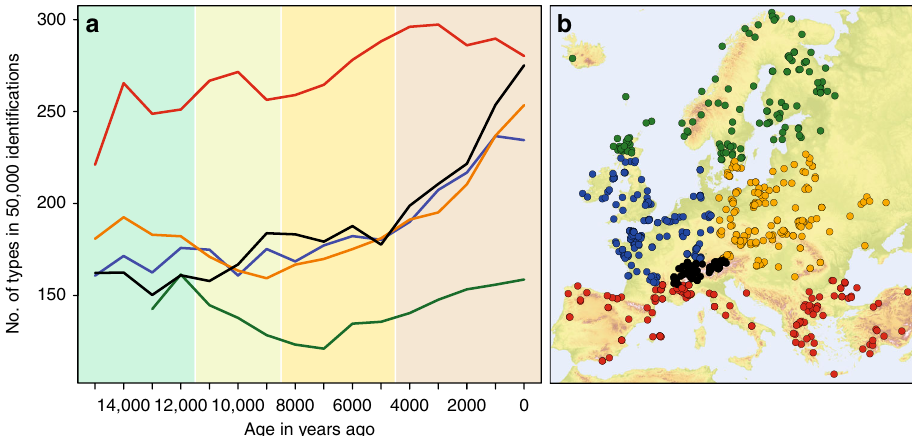
Fig. 1 Regional pollen type richness through time based on 749 pollen diagrams from Europe and Turkey. a Pollen type richness in regionally pooled samples with up to 10 7 identi fi cations per sample. Comparisons are made at a sample size of 50,000 identi fi cations using rarefaction based on all accepted types. Standard deviations are not shown due to their small values between 3 and 9. Line colours indicate regions: green = Boreal, blue = Temperate Oceanic, orange = Temperate Continental, red = Meridional/Submeridional, black = Alps. Time-periods (rounded to the nearest 0.5 ka) indicated by background colours: Lateglacial — 11.5 ka — Early Holocene — 8.5 ka — Middle Holocene — 4.5 ka — Late Holocene. b Locations of pollen diagrams used in the analysis. The colouring of the locations corresponds to the line colours of the regions in ( a ). Digital elevation data for Fig. 1b was obtained from the European Environment Agency (EEA).